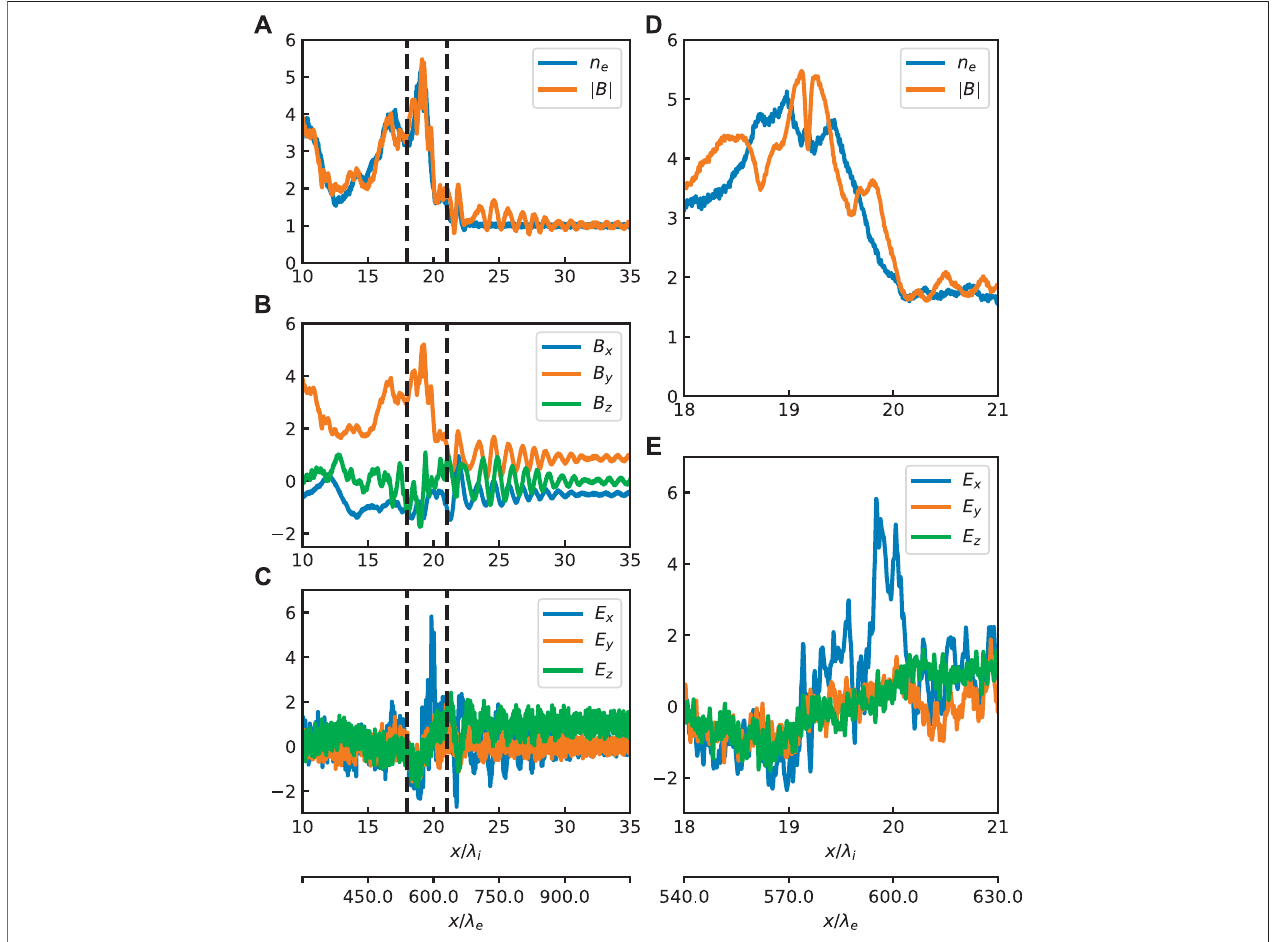
FIGURE 4 | An example taken from a PIC simulation with the shock normal along the x -direction. Each plot shows a 1D cut through the middle of 2D simulation domain.Panel (A) shows themagnetic fi eldmagnitude, B (orange),and the electron number density, n e (blue), vs. spatial position x .Panels (B , C) showthecomponents of magnetic fi eld (B) and the electric fi eld (E) . Panels (D , E) show a zoomed region of panels (A , C) respectively. The boundaries of the zoomed region are indicated by vertical dashed lines in panels (A – C) . All fi elds are measured in the simulation frame, where the shock moves in the positive x direction with the speed of ∼ 2 V A